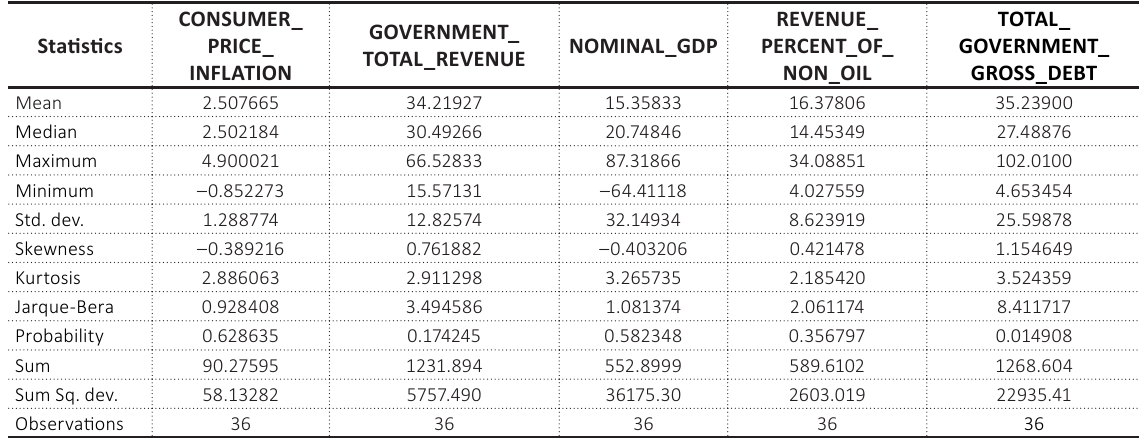
Table 7. Descriptive statistics of each variable used in the study